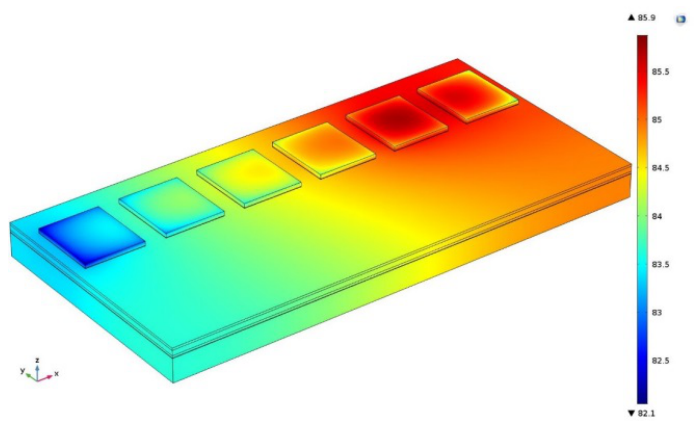
Figure 22. Temperature profile of GaN model with heatsink not